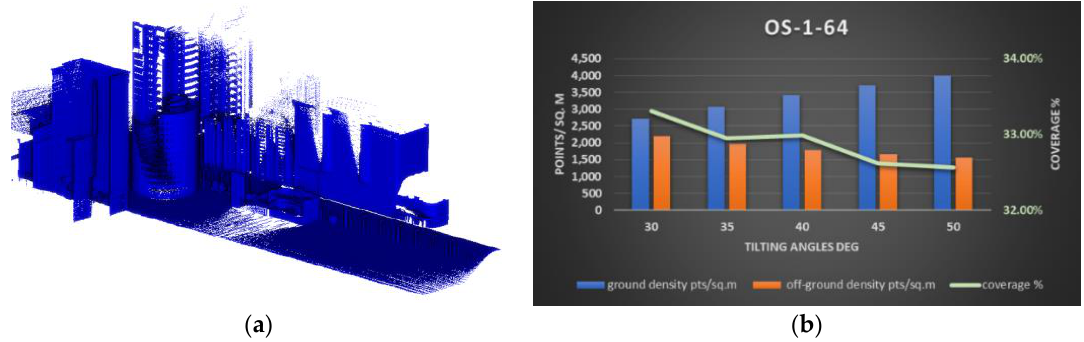
Figure 20. Point cloud density of OS-1-64 on the ground and off ground features and their achieved Figure20. PointclouddensityofOS-1-64onthegroundandoffgroundfeaturesandtheirachievedcoverage percentage. ( a ) Point cloud @30 ◦ . ( b ) Graphical representation of the coverage and density achieved. coverage percentage. ( a ) Point cloud @30˚. ( b ) Graphical representation of the coverage and density achieved.